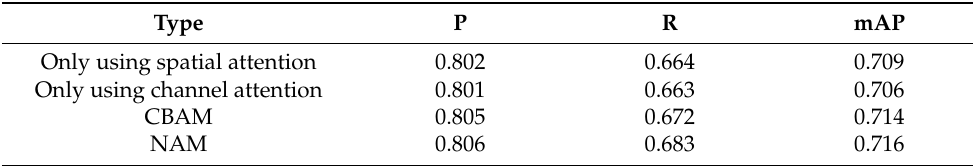
Table 6. The effects of using the attention method.